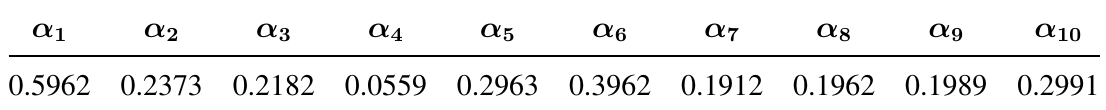
Table 2. Estimated coefficients of the proposed forecasting model.